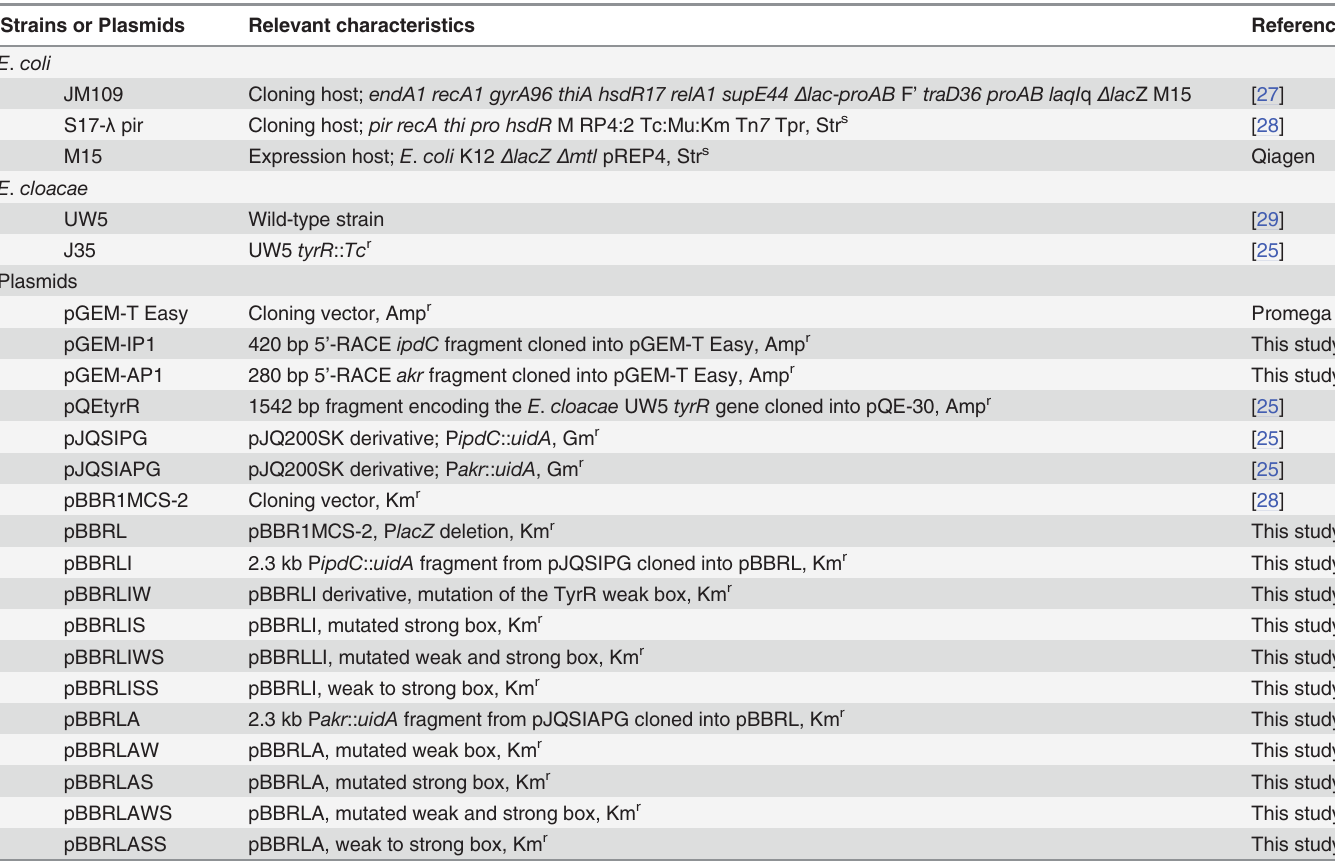
Table 1. Bacterial strains and plasmids used in this study. Strains or Plasmids Relevant